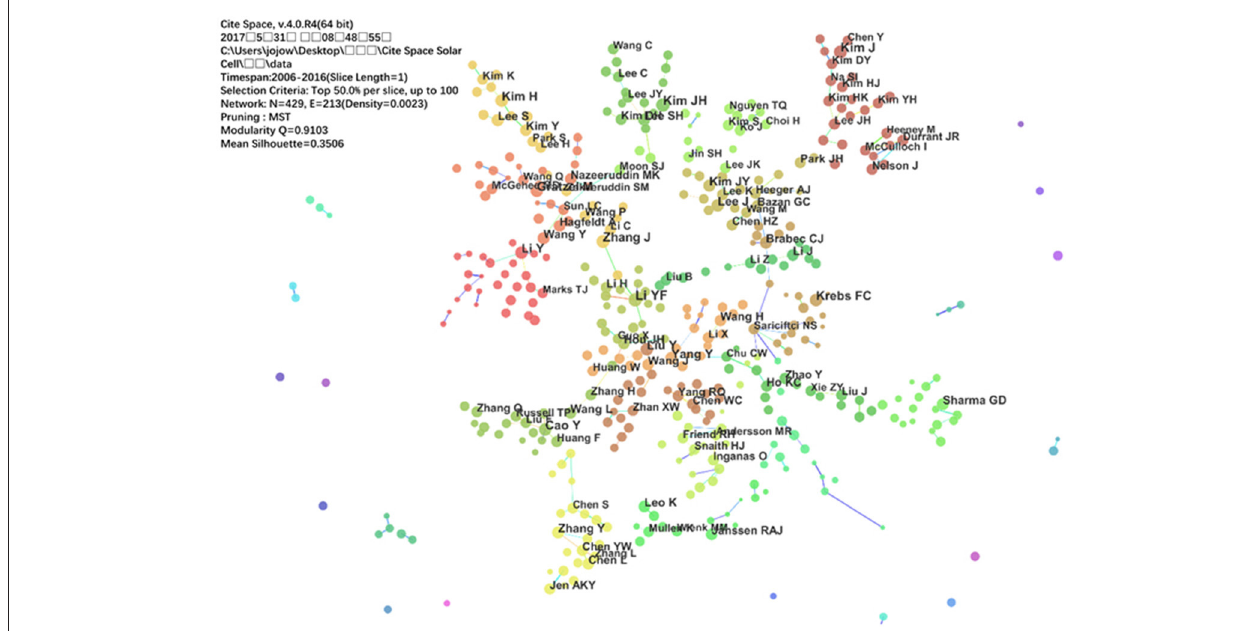
FIGURE 2 | The cooperation network of productive authors.